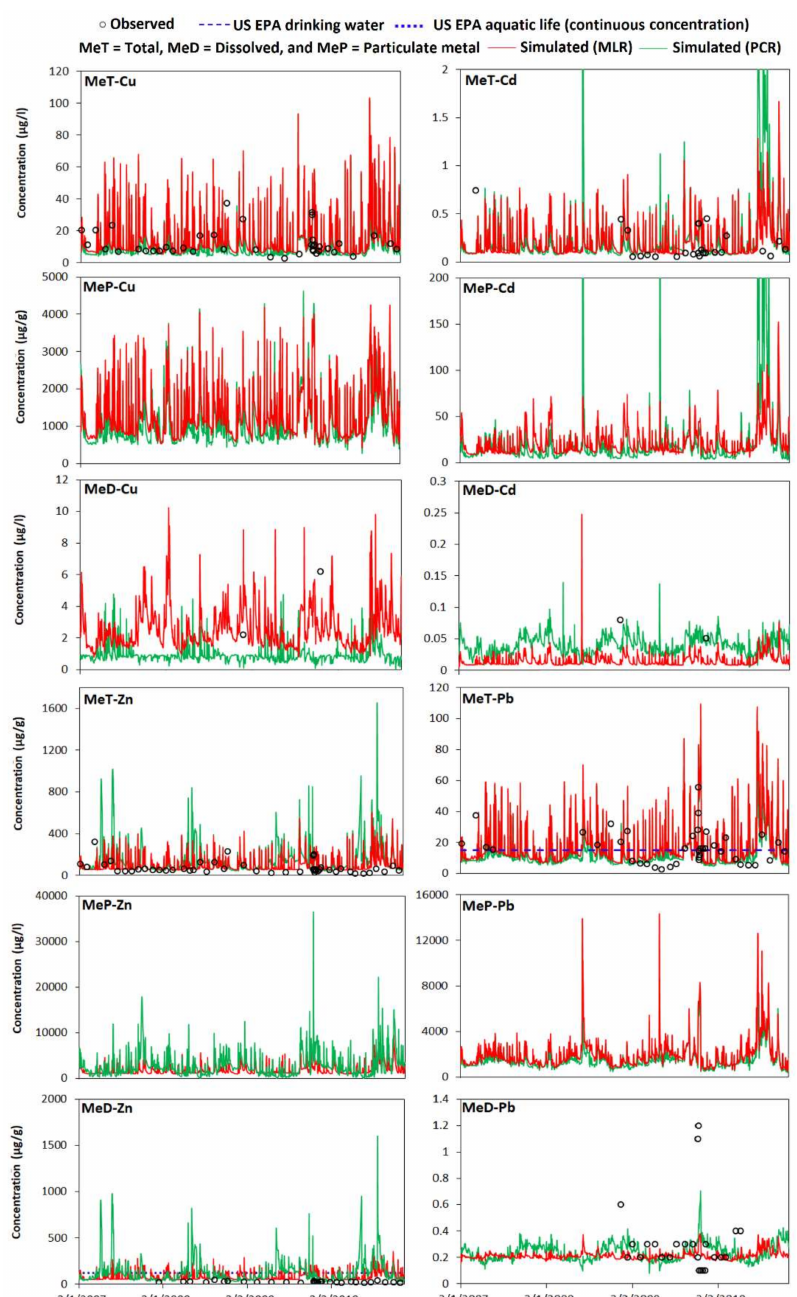
Figure 5. Multi-linear regression (MLR) and principle component regression (PCR) based simulated (daily aggregated) and observed total (MeT), dissolved (MeD) and particulate (MeP) metal concentration for Cu, Cd, Zn and Pb for the time frame of